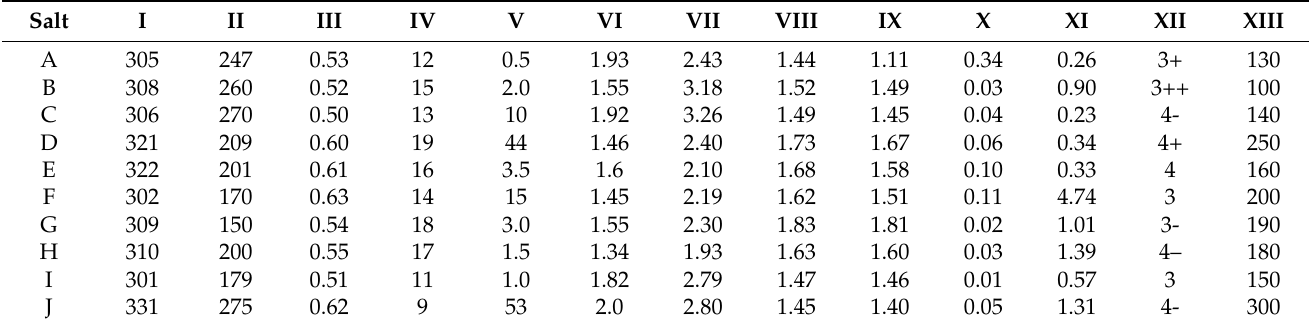
Table 3 presents the physical characteristics of selected salts marked with Roman numerals. Table 3. Physical characteristics of selected salts (HSMs).